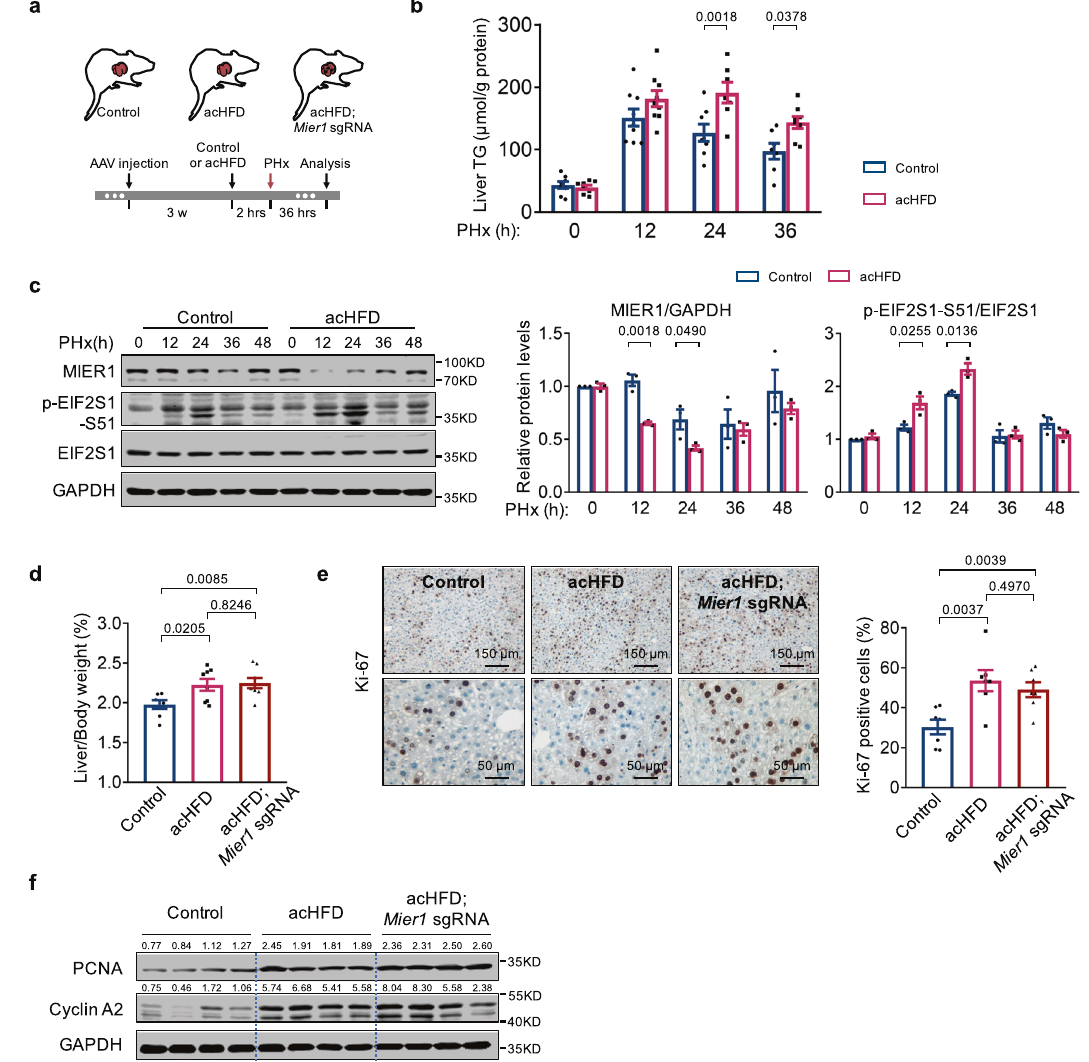
Fig. 6 | Acute HFD treatment improves liver regeneration. a Schematic pre- sentationofacuteHFD(acHFD)treatment.TheliverTGcontent( b )( n =8,9,8,7in Controlgroup,and n =8,9,7,8inacHFDgroup,indifferenttimepointsafterPHx), andliverimmunoblotsofMIER1andEIF2S1phosphorylation( c )( n =3)inControlor acHFD animals before or after hepatectomy. The liver/body weight ratio (%) ( d ) (Control, n =7; acHFD, n =8; acHFD; Mier1 sgRNA, n =8), liver Ki-67 staining ( e ) ( n =7),and liver immunoblots (PCNA,CyclinA2and GAPDH)( f ) in Control, acHFD,